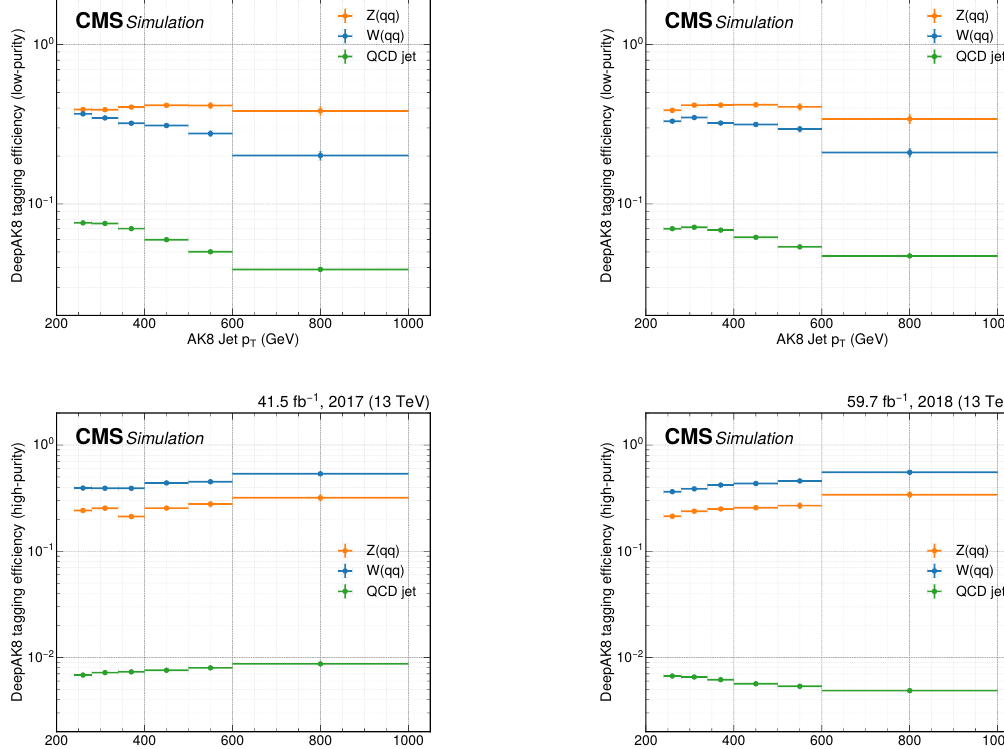
Figure 24 . Large-radius jet tagging efficiencies for use in reinterpretation of the results. The efficiencies are shown separately for the low- and high-purity selections in the upper and lower panels, respectively, and for the 2017 (left) and 2018 (right) data taking periods. The efficiencies include the effect of the DeepAK8 tagger, as well as the SD-corrected mass requirement. In each panel, individual curves represent the efficiency for different types of jets, based on whether the jets are matched to a generator-level W boson, Z boson, or neither (“QCD jet”). Simulation-to-data corrections are